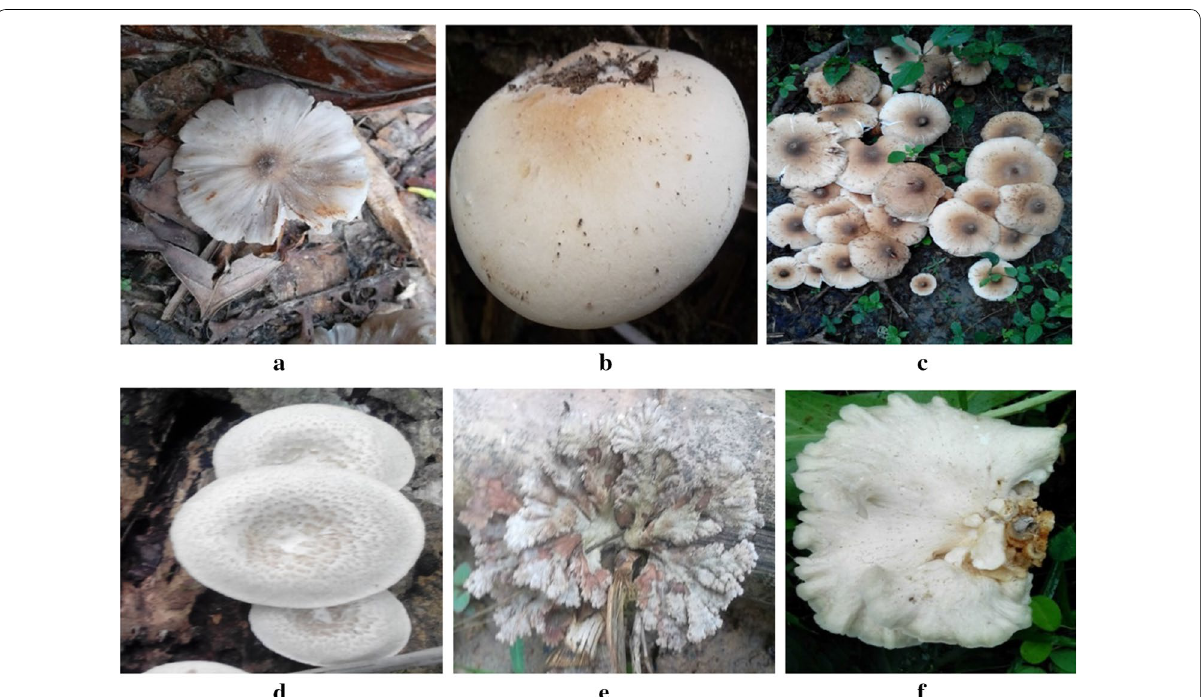
Fig. 1 Representative pictures of the different mushrooms. a Tricholoma matsutake , b Tricholoma robustum , c Termitomyces aurantiacus , d Pleurotus ostreatus , e Schizophyllum commune and f Pleurotus